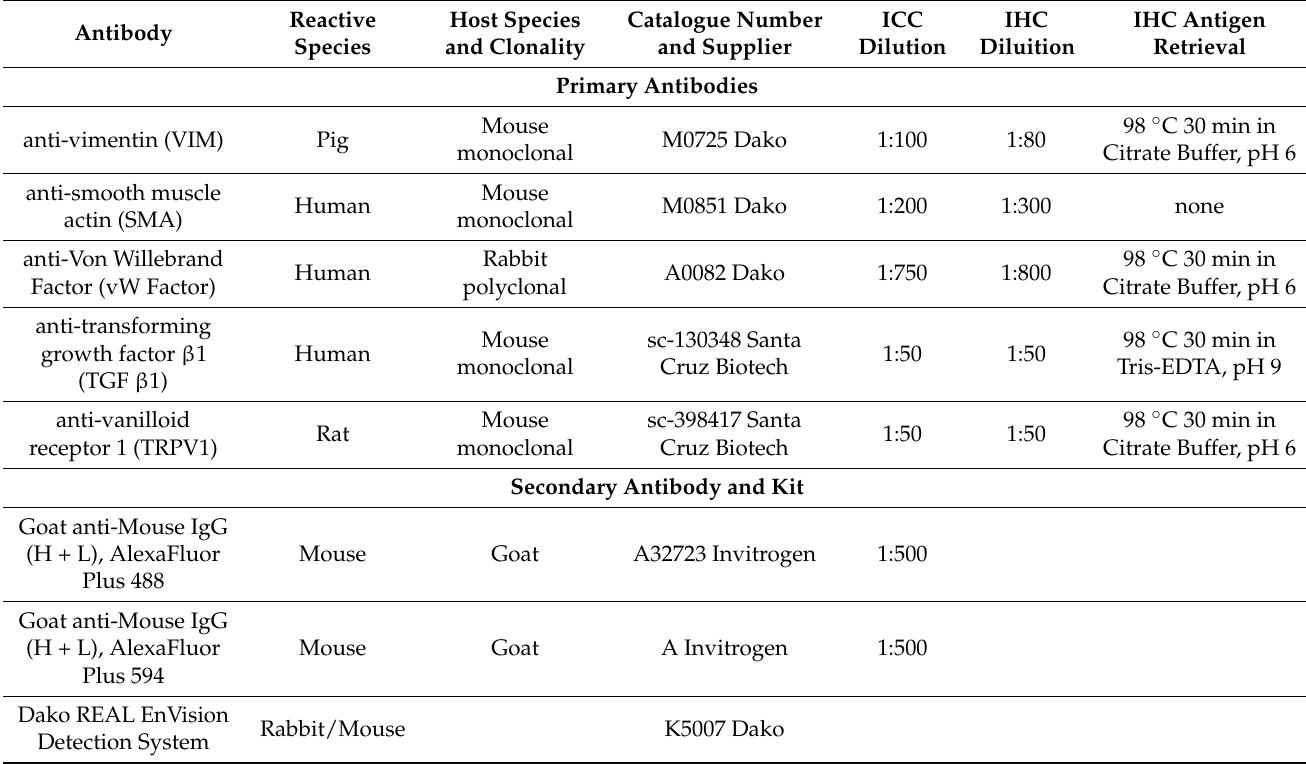
Table 1. Primary and the secondary antibodies and colorimetric detection kits used for immunocytochemistry (ICC), fluorescence, and immunohistochemistry